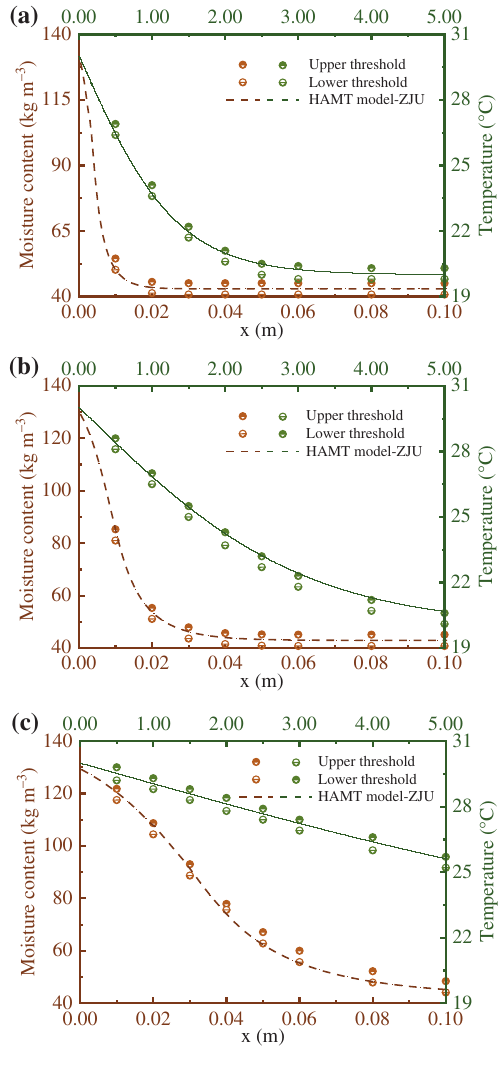
Comparison between the numerical simulation results of the HAMT model and the analytical solution of EN 15026: 2007 in temperature and moisture content profile on: (a) the 7th day, (b) the 30th day, and (c) the 365th